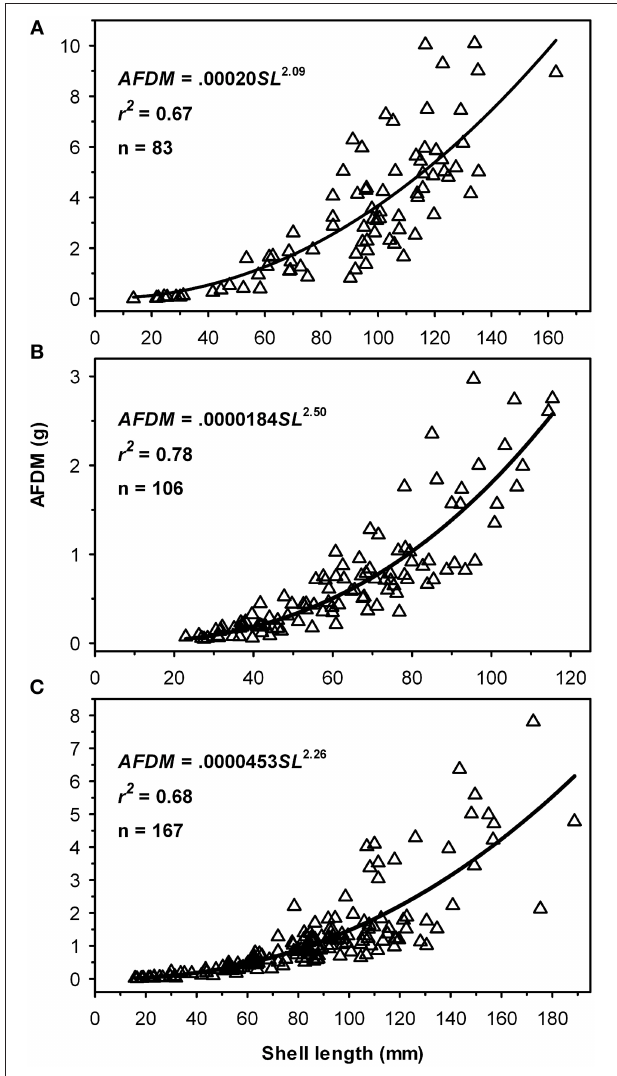
FIGURE 5 | Ash-Free Dry Mass (AFDM) as a function of oyster size for reefs in (A) Lynnhaven River, (B) Broad Bay, and (C) Linkhorn Bay.